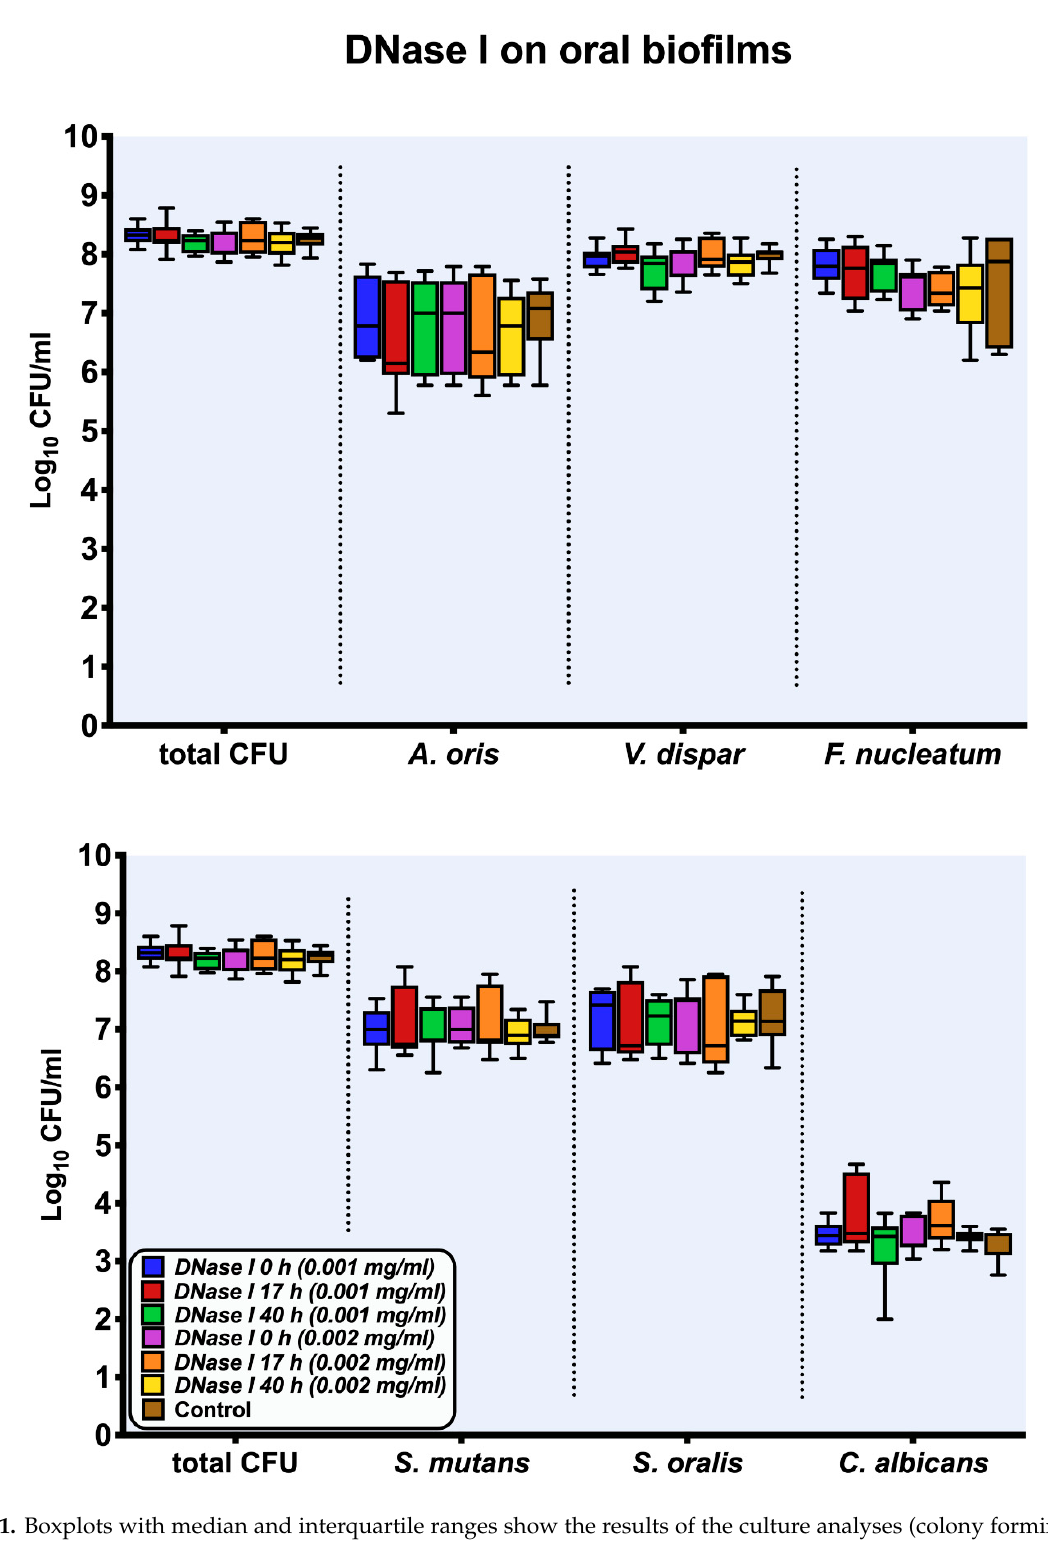
Figure 1. Boxplots with median and interquartile ranges show the results of the culture analyses (colony forming units (CFUs)) of the multispecies biofilms after one-hour exposure to DNase I (0.001 mg/mL, 0.002 mg/mL) at intervals of 0 h, 17 h, and 40 h, respectively. The untreated biofilms are presented as negative controls and CFUs are shown on a log 10 scale per milliliter (Log 10 /mL).